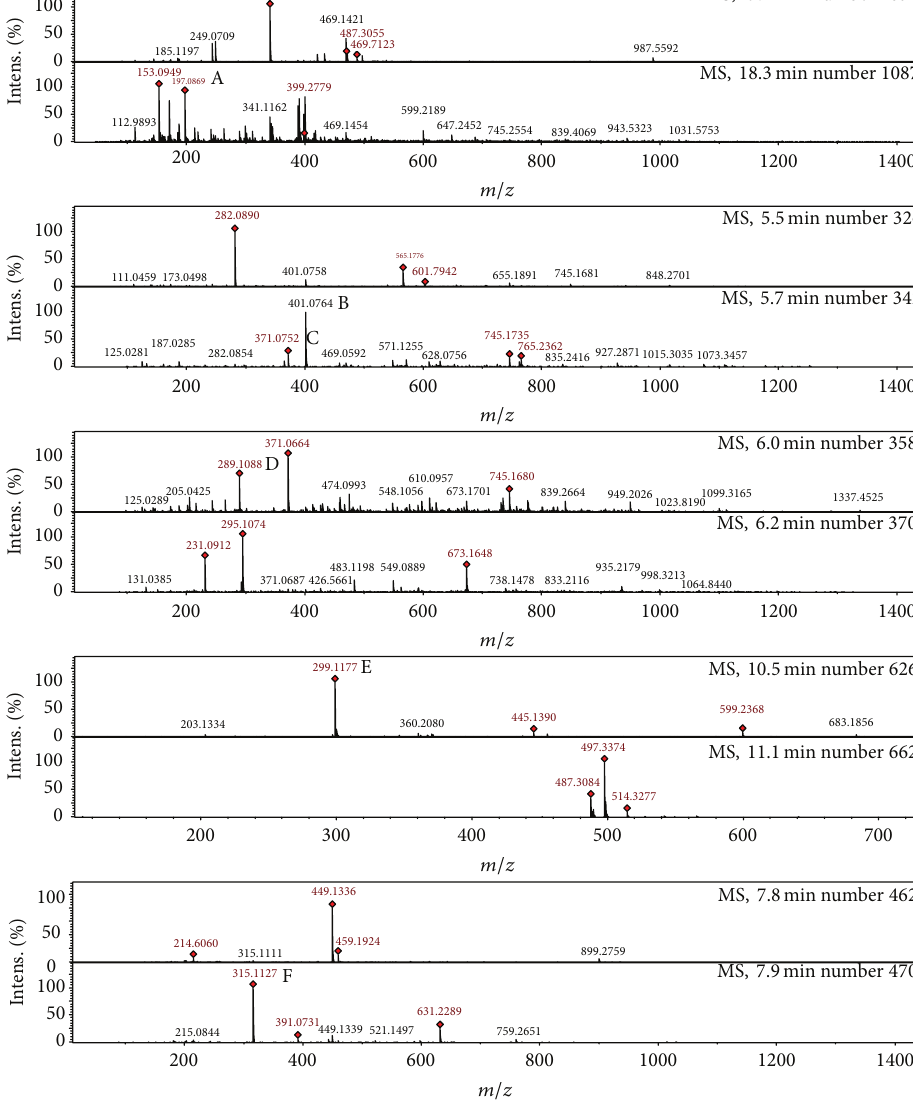
mean values of different plant extracts was determined by t - test using Graph Pad PRISM